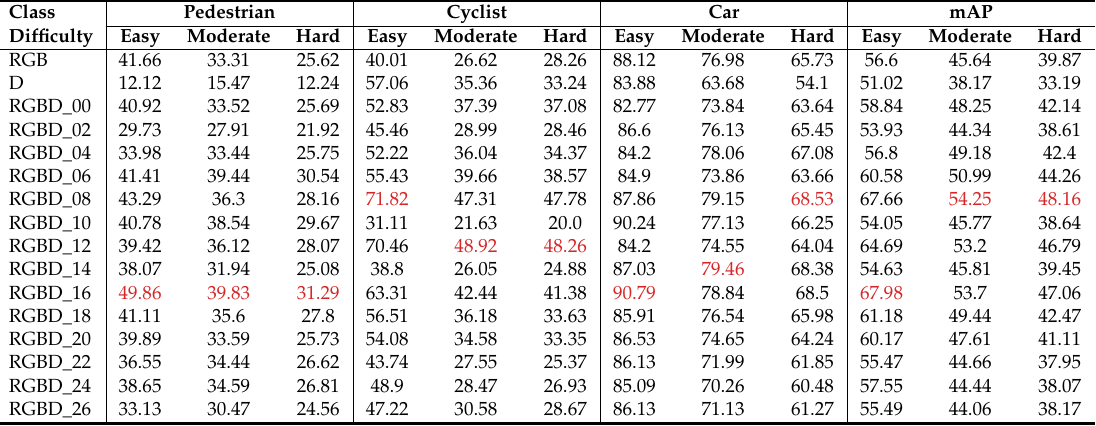
Table 1. AP values of our different models on the KITTI dataset. The best results are highlighted in red. Class Pedestrian Cyclist Car mAP Difficulty